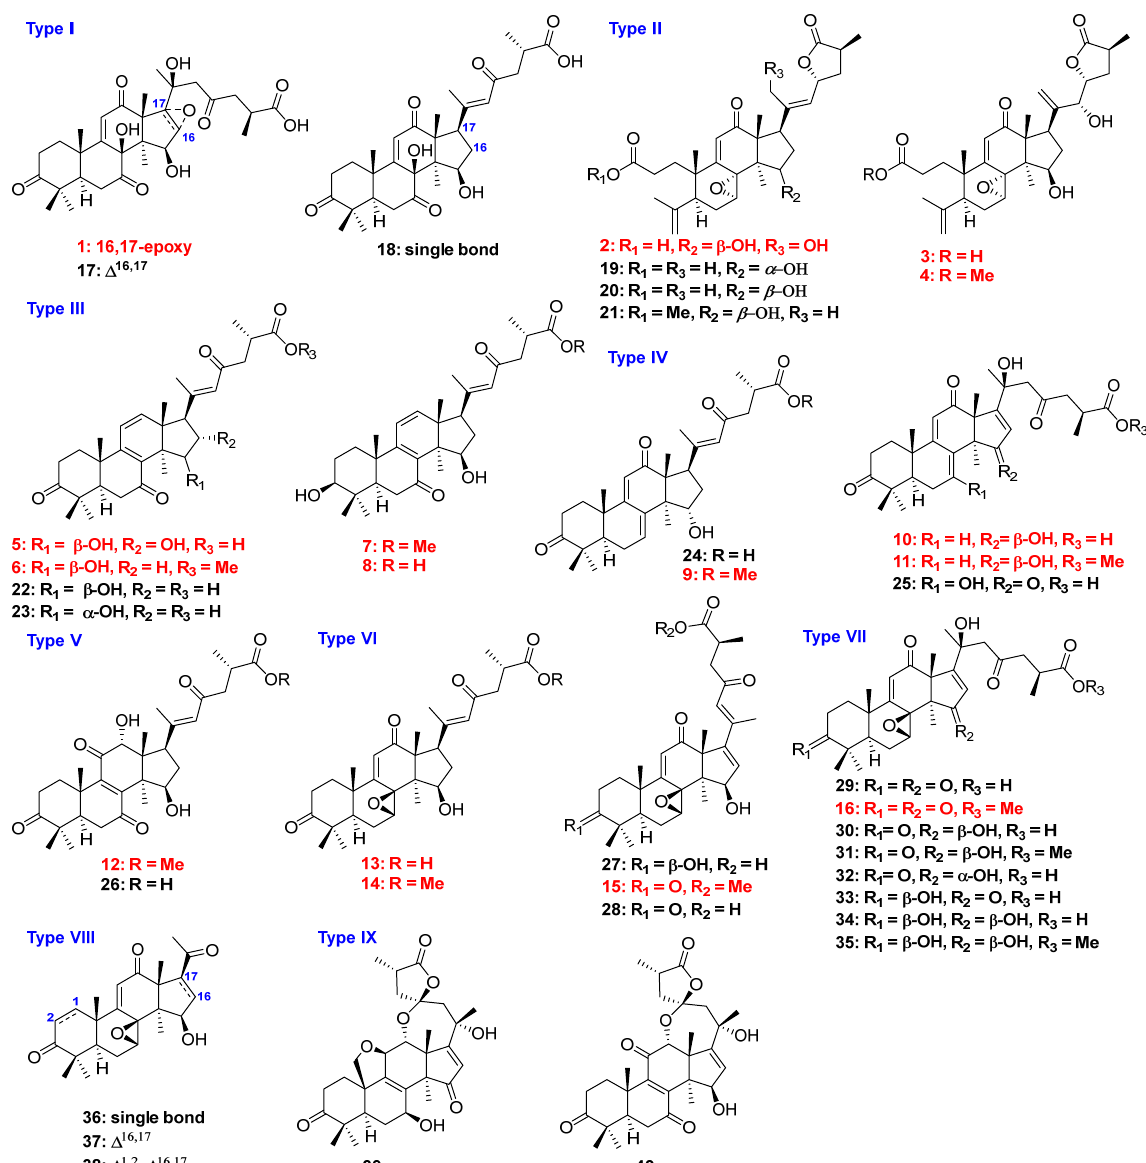
Figure 1. Structures and classifications of isolates from G. applanatum (red: new compounds).